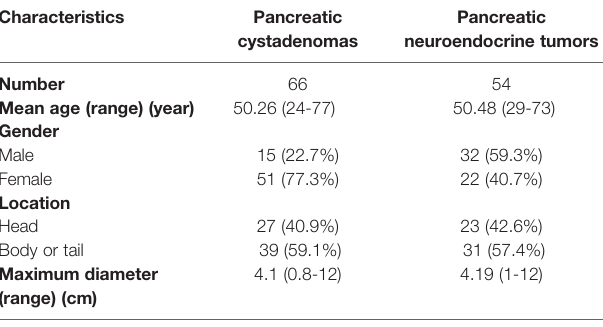
TABLE 1 | Characteristics of patients and lesions.